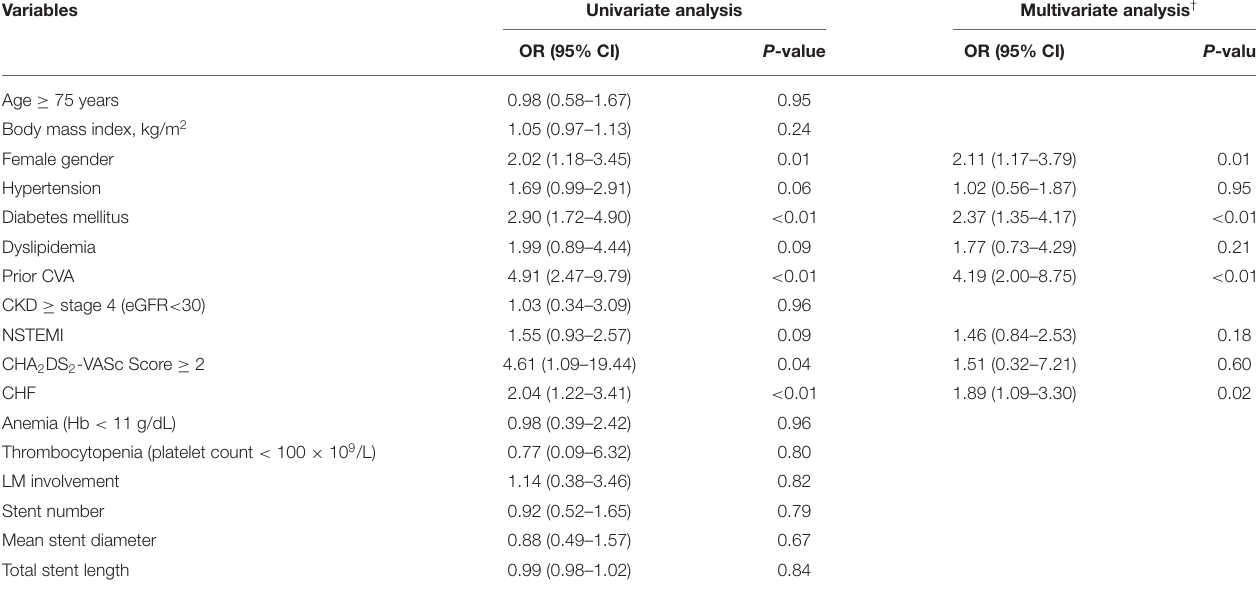
TABLE 5 | Univariate and multivariate analyses regarding the determinants for OAC